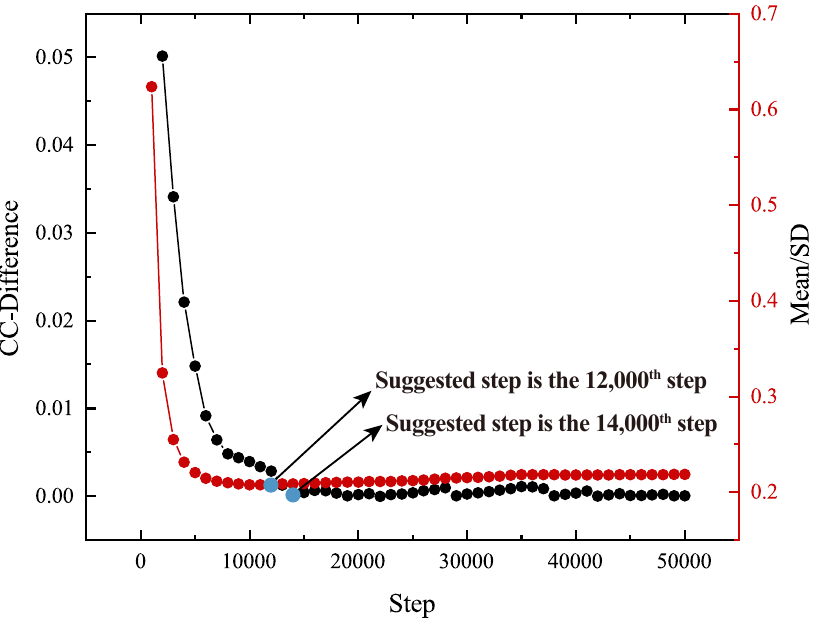
Figure 7. The comparison of the proposed method and the displacement-based